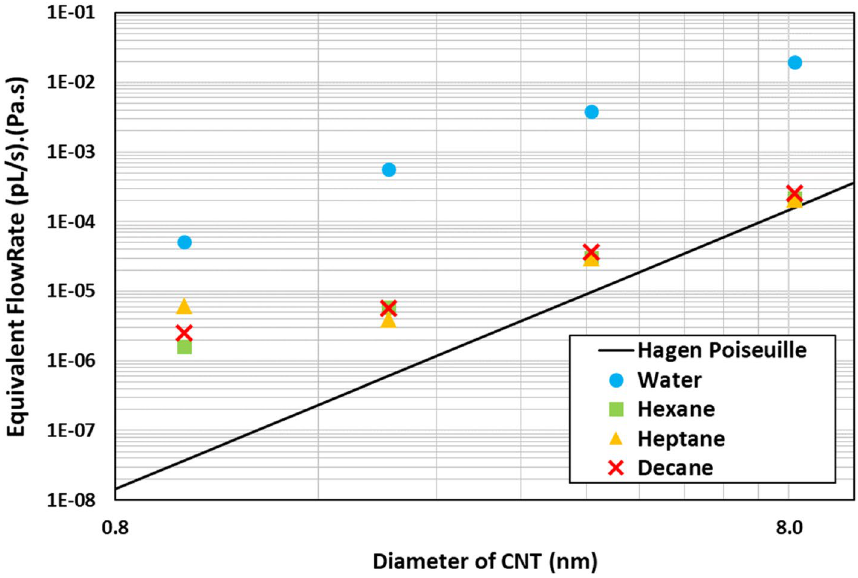
Figure 4. Flowrate of different fluid plotted against the radius of the CNT on a Log–Log scale. The black line represents the continuum line derived from Haggen–Poiseuille flow. The solid points represent the work produced from this study. The dashed lines are backward extrapolation to predict the flow rate at lower radii.